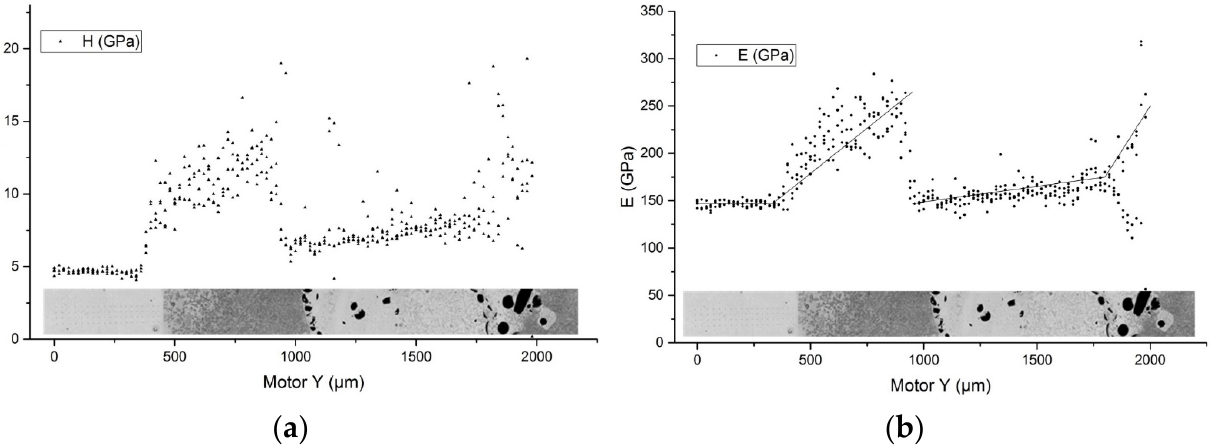
Figure 7. Dependence of hardness ( a ) and elastic modulus ( b ) on the place of measurement for the sample Ti64 + crushed fiber SiC.